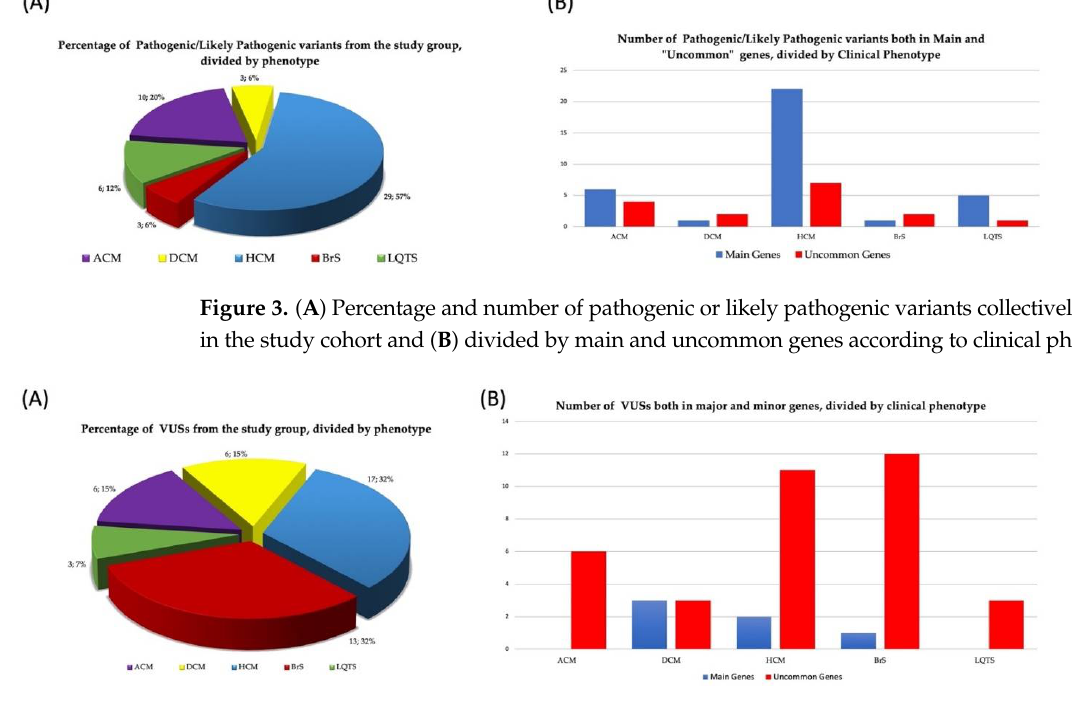
Figure 4. ( A ) Percentage and number of VUSs collectively identified in the study cohort and ( B ) divided by main and uncommon genes according to clinical phenotype.